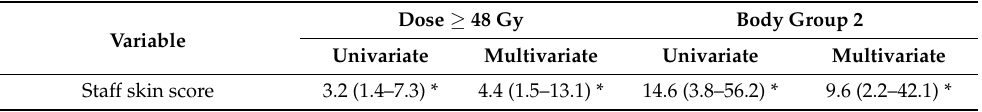
Table 5. Logistic regression results for predictors of MD. Odds ratios are given with 95% lower and upper confidence intervals in parentheses. Results with p < 0.05 are marked with an asterisk. Only variables with p < 0.1 were included in multivariate regression resulting in some entries for pain or fatigue not being